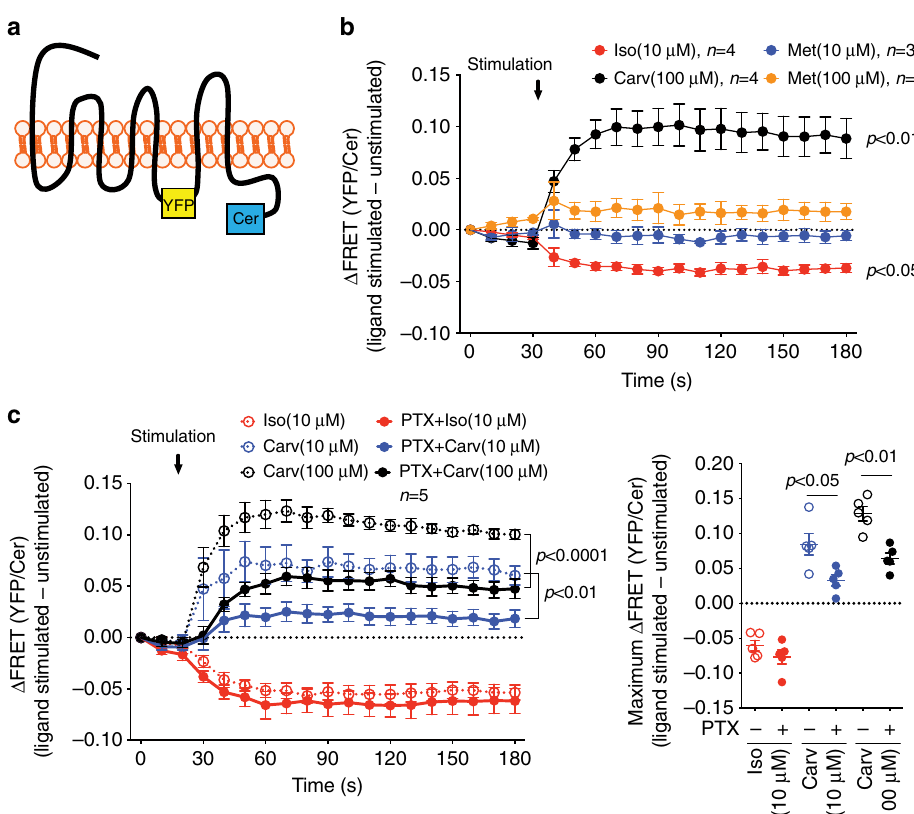
Fig. 2 G α i is required for carvedilol-induced β 1 AR conformation change. a In the FRET-based β 1 AR conformation sensor, YFP and Cerulean (Cer) are inserted in the third intracellular loop and the C-tail of β 1 AR respectively. b Ligand-induced changes of the FRET ratio in HEK293 cells stably expressing β μ M carvedilol, 10 μ M isoproterenol, 10 μ M or 100 μ M β 1 AR FRET sensor. The stable cells were stimulated with 100 1 AR antagonist metoprolol, while FRET was monitored in real-time as the emission ratio of YFP to Cer. Carvedilol stimulation increased the FRET ratio, while isoproterenol decreased it, demonstrating the distinct β 1 AR conformations induced by these two ligands. Metoprolol had no effect on the FRET ratio. c Effect of PTX on ligand-induced FRET ratio change. Cells were pretreated with vehicle or 200 ng per ml PTX for 16 h before ligand stimulation. PTX blocked carvedilol-induced change, while having no effect on the isoproterenol response, suggesting that G α i is required to stabilize the carvedilol-induced β 1 AR conformation. Data represent the mean ± SEM for n independent experiments as marked on the fi gure. Statistical signi fi cance vs. unstimulated cells was assessed using one-way ANOVA with Bonferroni correction ( b ); statistical signi fi cance between PTX-pretreated and non-pretreated cells was assessed using two-way ANOVA with Bonferroni correction ( c , left panel), or two-tailed paired Student ’ s t -test ( c , right